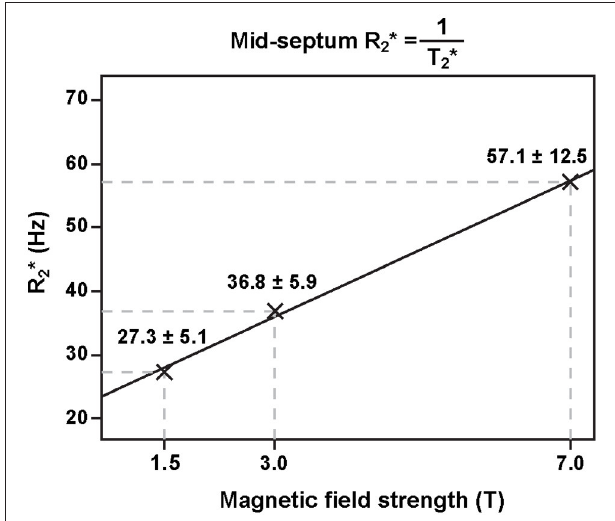
FIGURE 2 | Relation of ventricular septal R 2* and static magnetic field strength. Myocardial R 2* increases linearly with magnetic field strength (adapted from Meloni et al. [ 36] with permission from John Wiley and